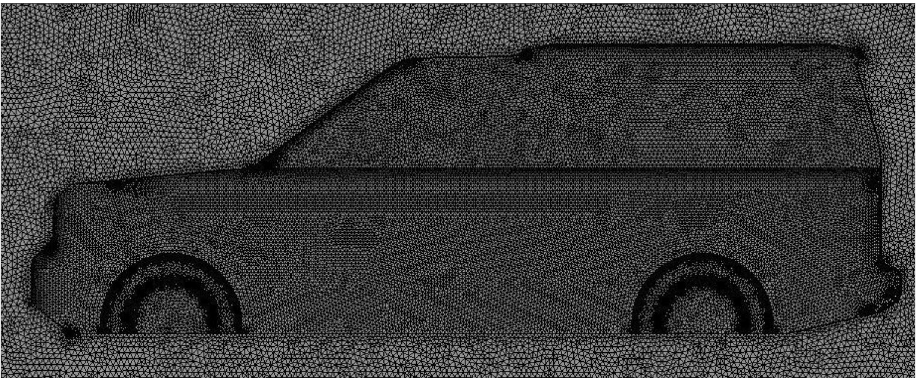
Figure 4. Tetrahedral mesh with 5 prism layers over the surfaces of the